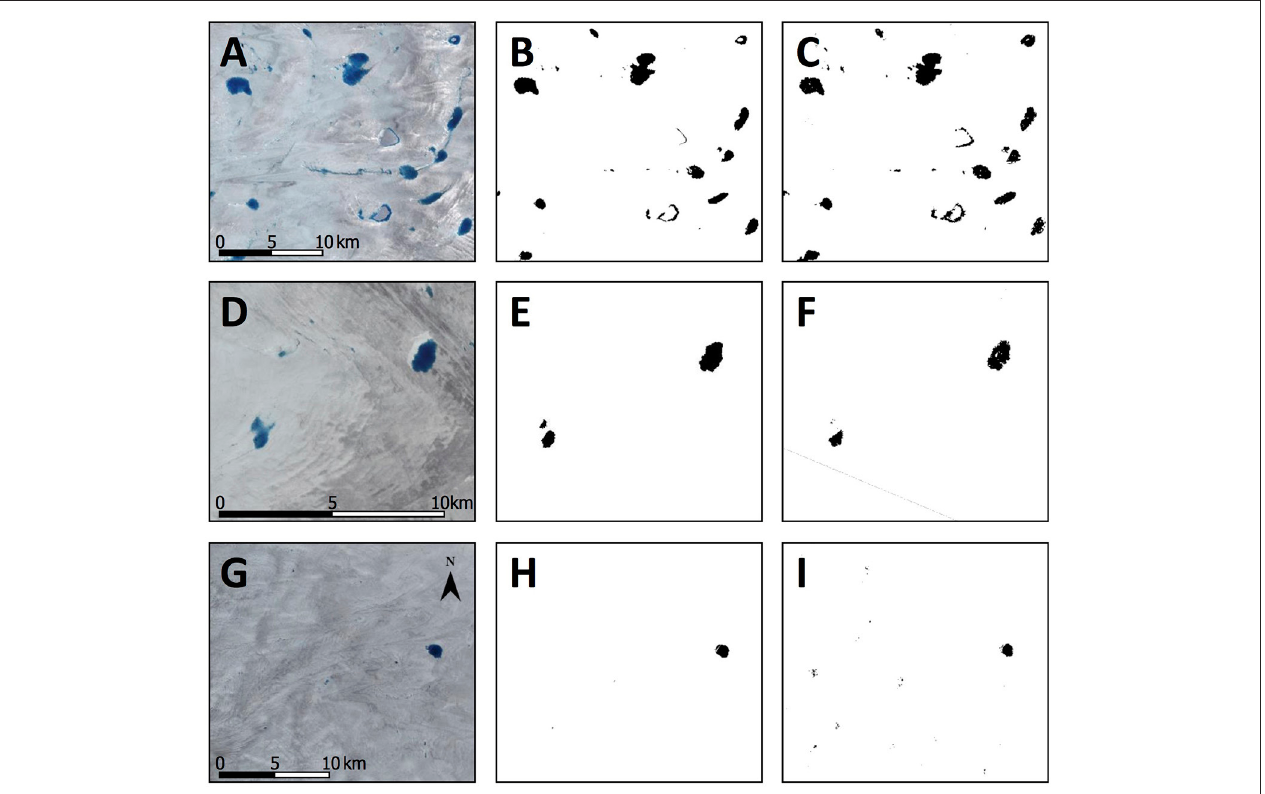
FIGURE 7 | Examples of lake classifications, with Landsat RGB false-color images for reference (A,D,G) , classified by the Landsat NDWI (B,E,H) and Sentinel-1 (C,F,I) . Locations within the study region are shown in Figure 1 . Subsets (A–C) were acquired on day 189 (2015); subsets (D–F) were acquired on day 212 (2015); subsets (G–I) were acquired on day 237